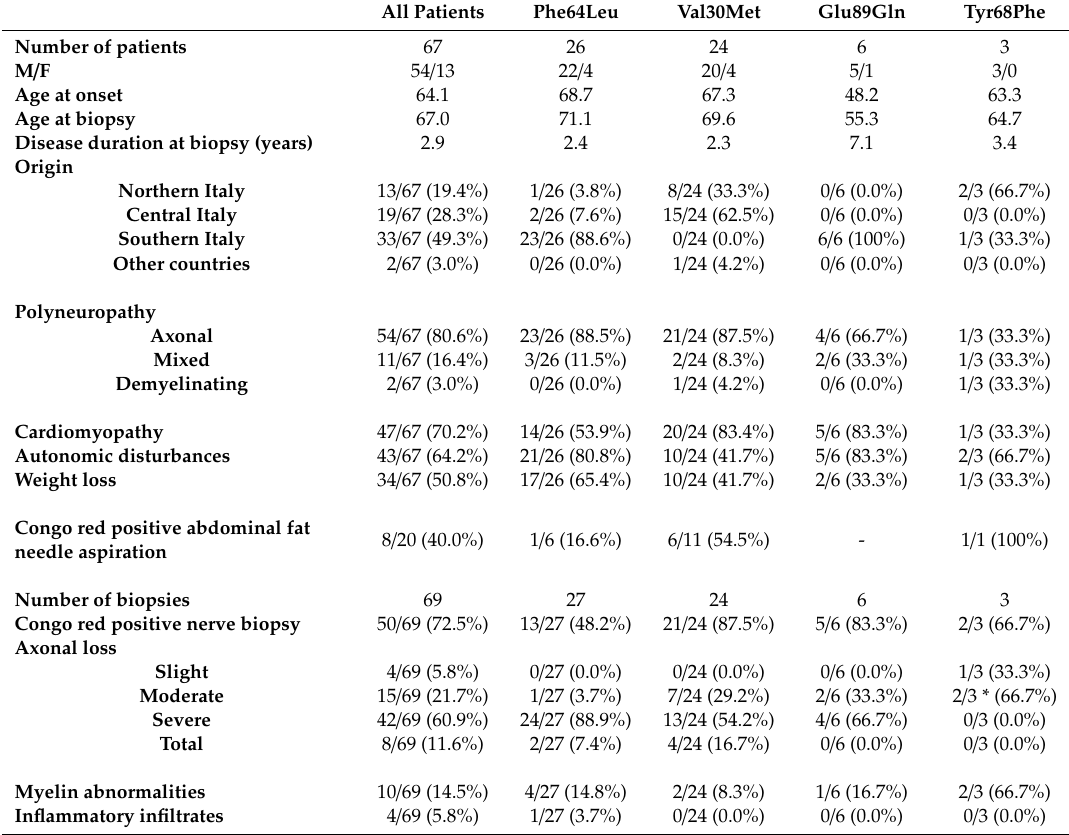
Table 1. Demographic, clinical and pathological findings of the entire hATTR cohort and of the most frequently detected